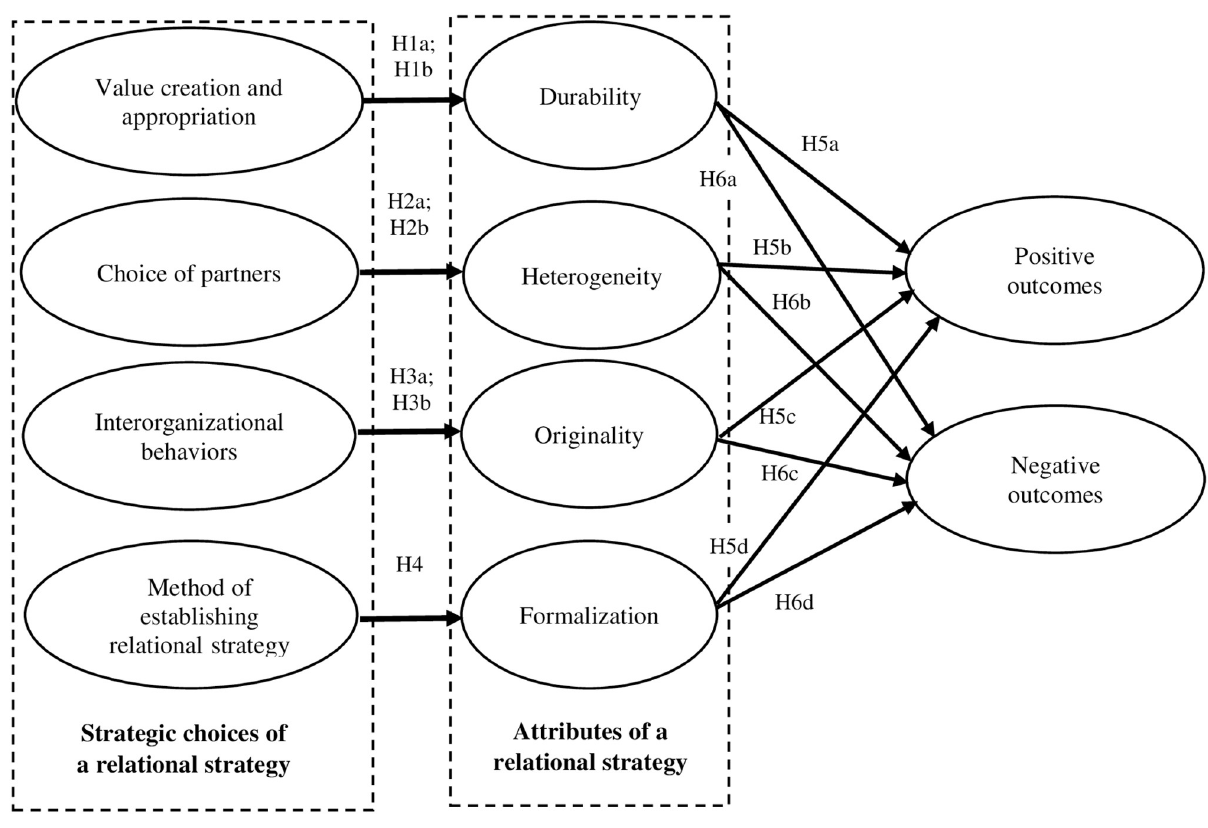
Fig 1. Conceptual